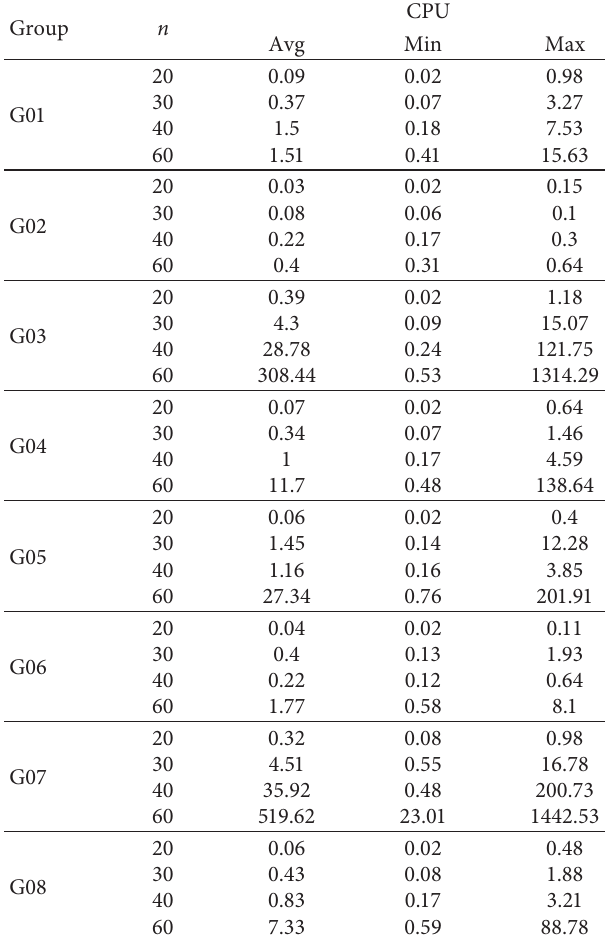
Table 1: CPU time of CPLEX solutions in the LPP problem.